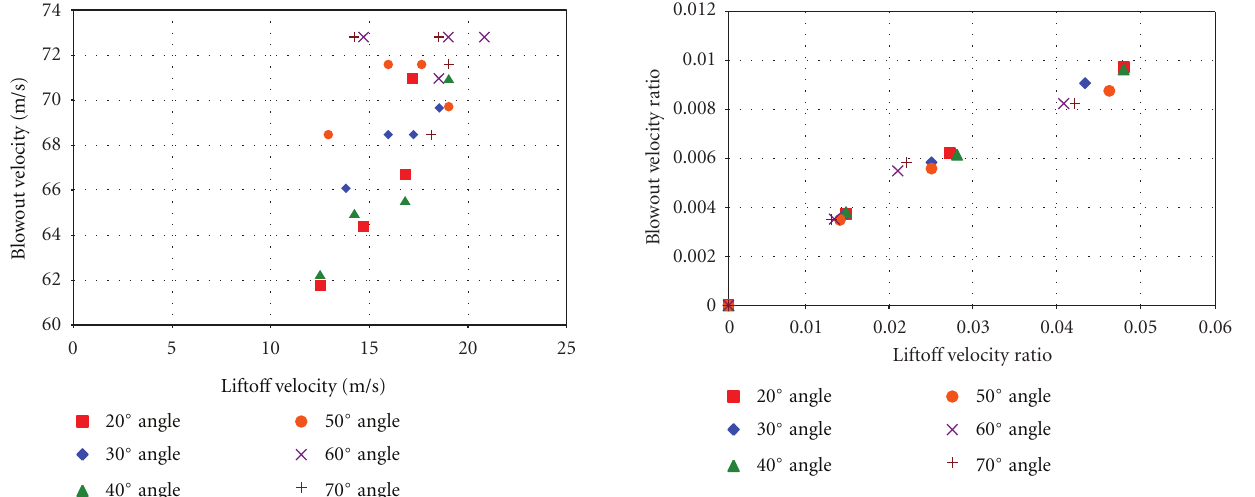
Figure 7: Blowout velocity ratio versus lifto ff velocity